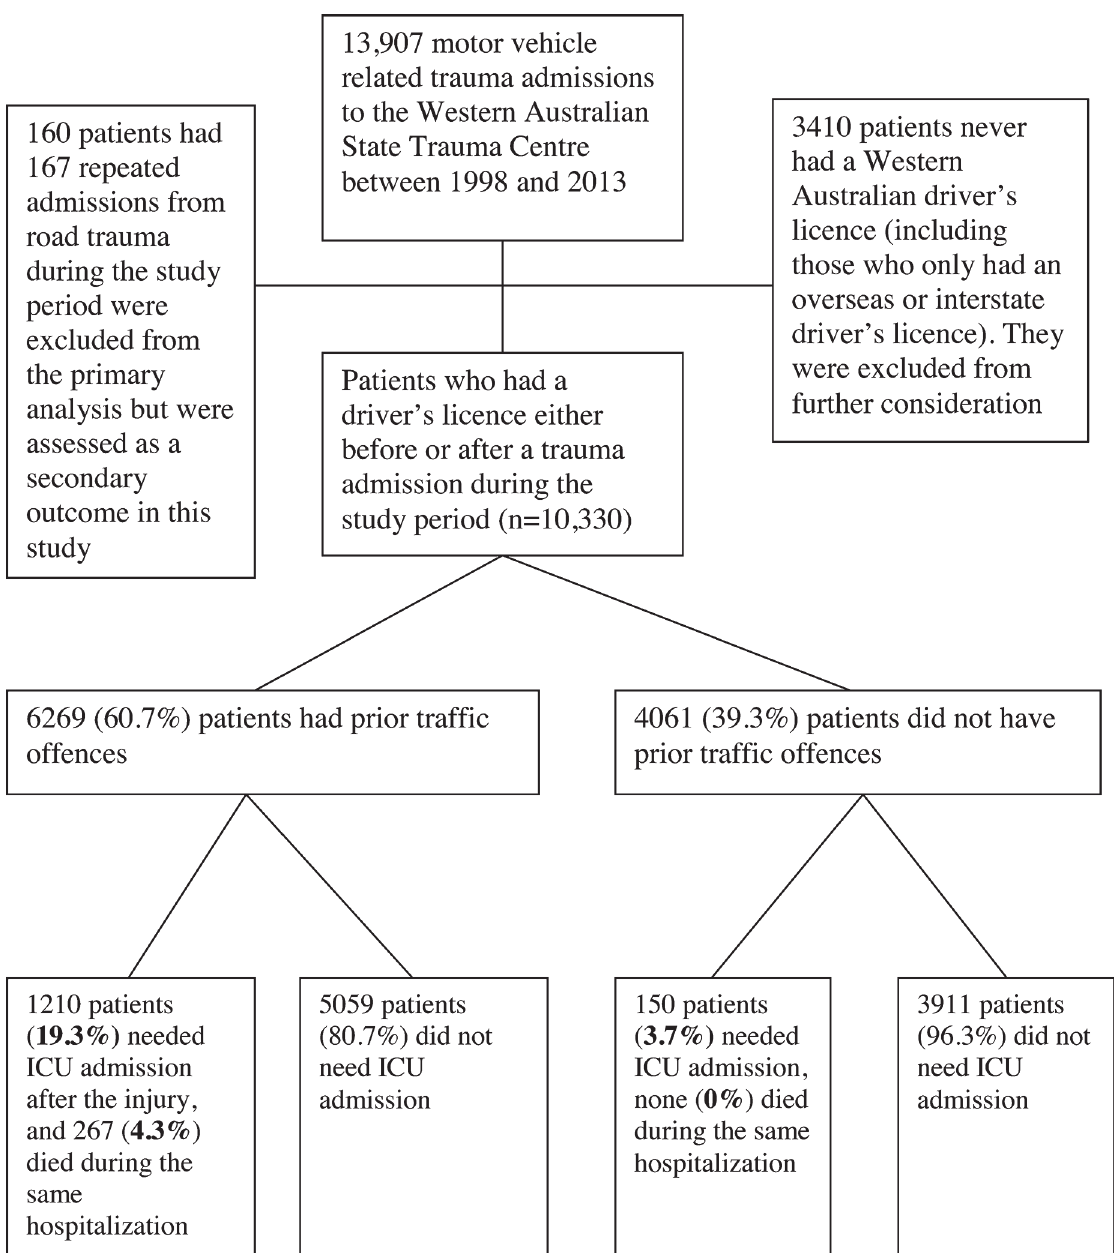
Fig 1. Flow chart showing inclusion and exclusion of patients for the study. ICU, intensive care